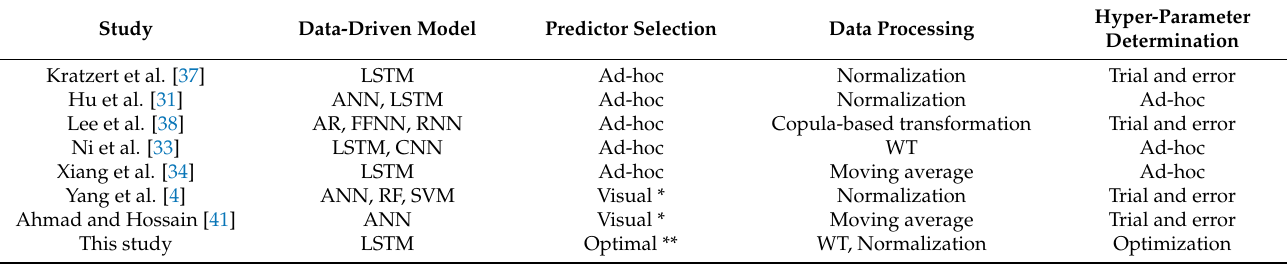
Table 1. Streamflow prediction studies using a data-driven